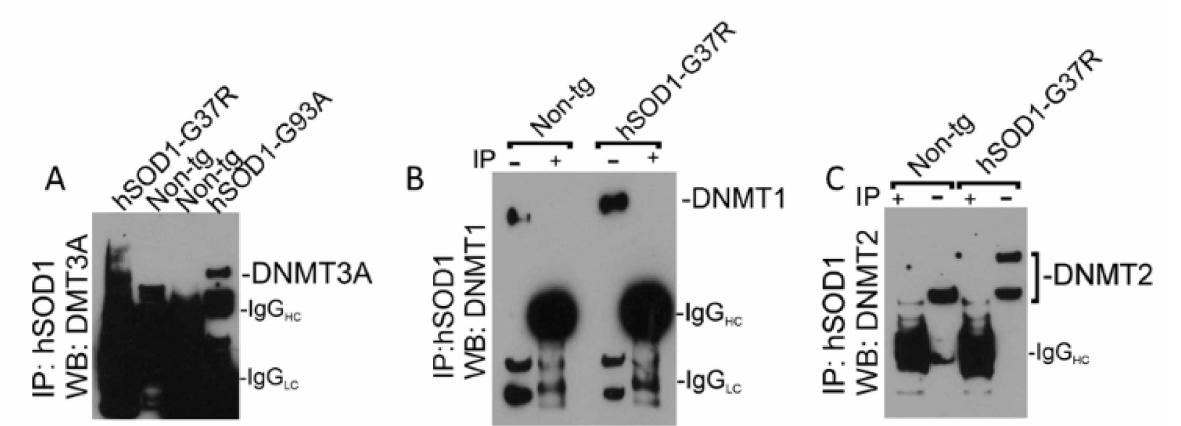
Figure 7. Co-IP identified an interaction between hSOD1 and specific isoforms of DNMTs in skeletal muscle. ( A ) IP of skeletal muscle tissue lysates with human-specific antibody to capture hSOD1 followed by Western blotting (WB) of captured protein for DNMT3A identified co-precipitation of DNMT3A with hSOD1-G37R and hSOD1-G93A but not in skeletal muscle lysates of non-tg mice. Heavy chain IgG (IgG HC ) and light chain IgG (IgG LC ) are indicated at ~50 kDa and ~25 kDa, respectively. Very long exposures were required to visualize the DNMT3A bands making the IgG bands overexposed and smudged. ( B ) Co-IP of hSOD1 and DNMT1 was not found, but DNMT1 was detected in skeletal muscle tissue lysate used for input to IP (IP minus lanes). +, denotes hSOD1 antibody was added to the skeletal muscle homogenate. -, denotes hSOD1 was not added to the skeletal muscle homogenate. ( C ) A minor fraction of 60 kDa DNMT2 co-precipitated with hSOD1. DNMT2 was detected in skeletal muscle tissue lysate used for input to IP (IP minus